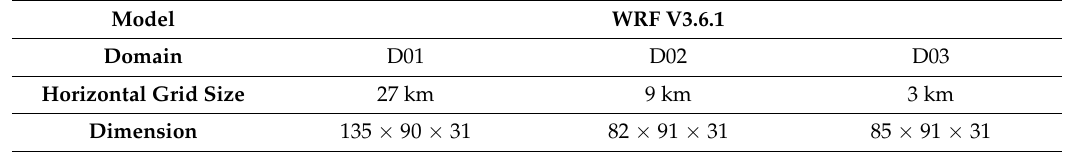
Table 1. Summary of the Weather Research and Forecasting (WRF) model